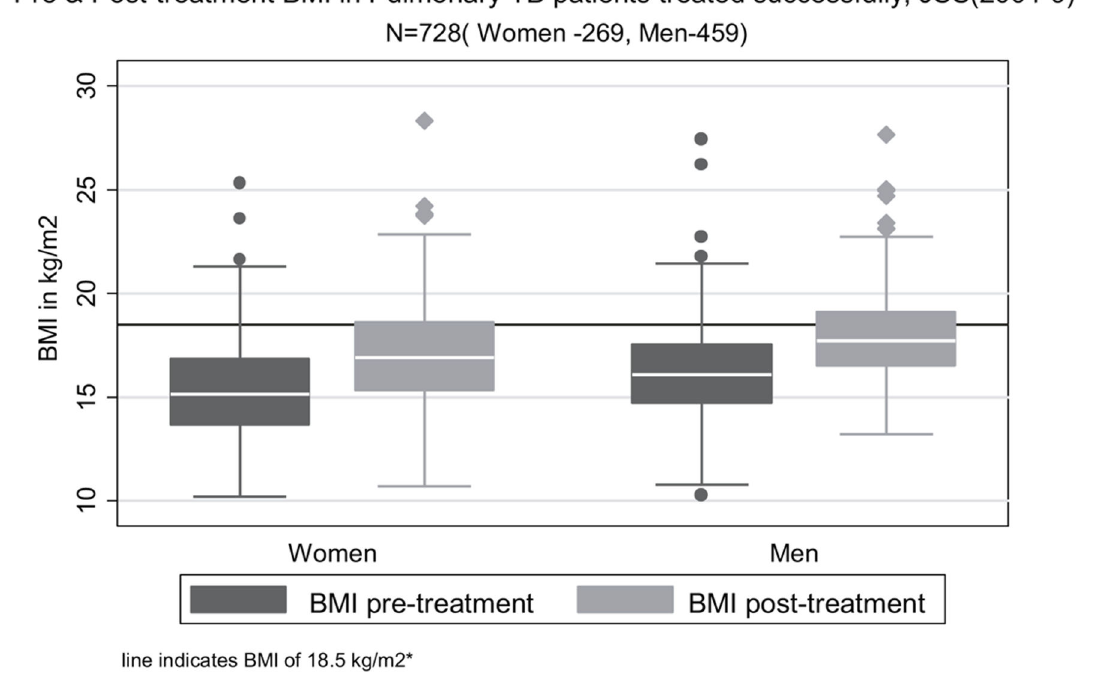
Figure 2. Distribution of pre-treatment and post-treatment body mass index (BMI) of adult patients with pulmonary tuberculosis treated successfully at JSS, 2004-2009. *BMI of 18.5 kg/m 2 is the cutoff separating under-nutrition (BMI<18.5 kg/m 2 ) from normal range of BMI (18.5-24.99 kg/m 2 ). doi: